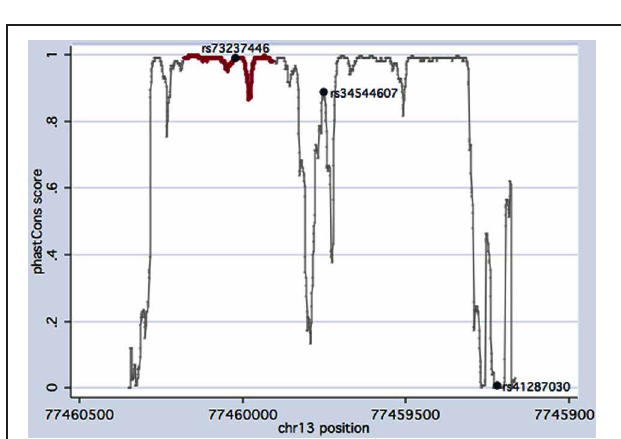
FIGURE 3 | Comparative genomic analysis of the KCTD12 sequence screened. Only confirmed variants are shown. F87F (rs73237446) and T178T (rs34544607) map to regions ( x -axis) highly conserved in primates. Conservation scores ( y -axis) for the potassium channel tetramerization domain (delimited by residues 36 and 125) are plotted in